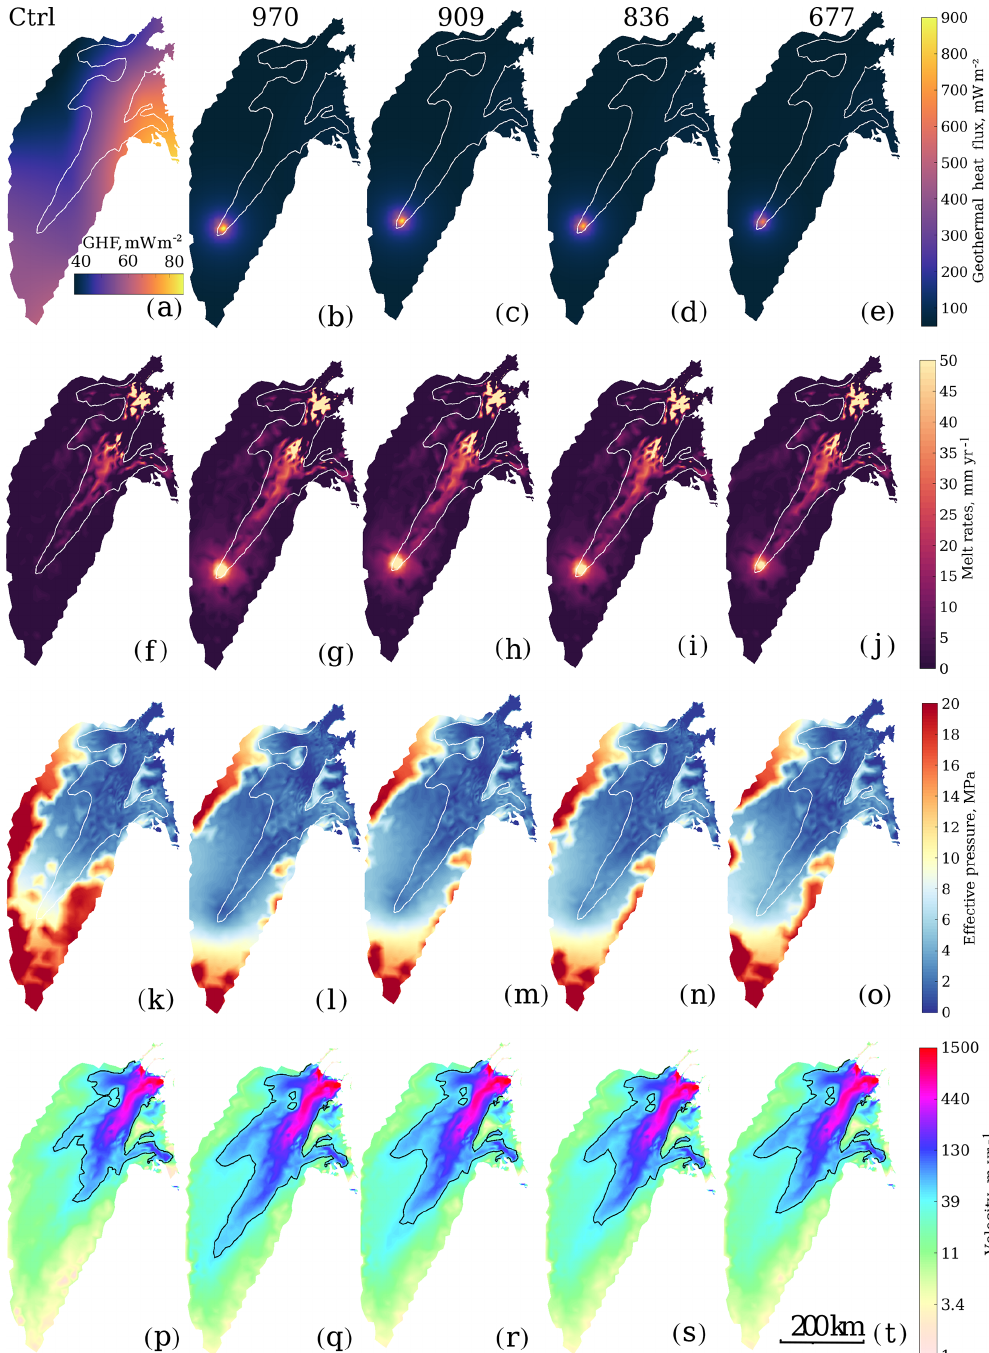
Figure 2. Model results for the control simulation and the plume677, plume836, plume909 and plume970 simulations. Panels (a–e) show the modelled GHF (note the different colour scale for the control simulation) and (f–j) show the corresponding basal melt rates, forcing the hydrology model which computes the corresponding effective pressure (k–o) and finally the resulting surface velocity (p–t) . White lines show the 50myr − 1 observed velocity contour, and black lines show the 50myr − 1 modelled velocity